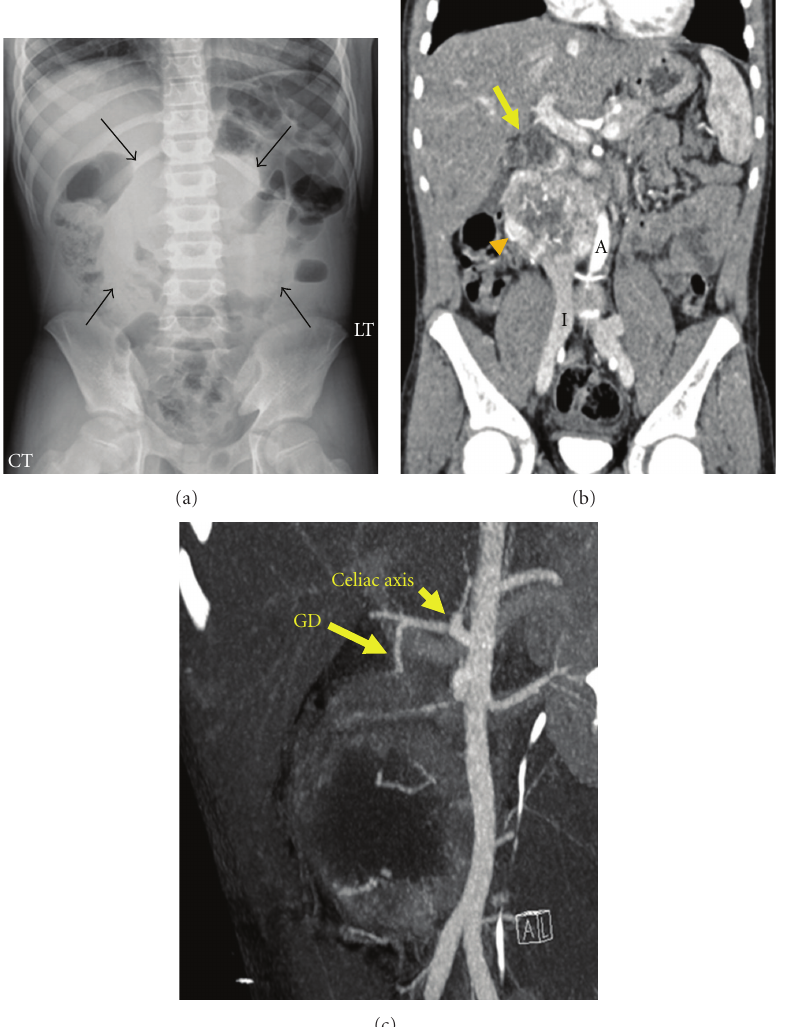
Figure 1: (a) Abdominal radiograph shows midline displacement of bowel loops by a soft tissue density (black arrows) without calcifications and no bowel obstruction. (b) Coronal CTA shows the markedly enhancing mass (orange arrowhead) displacing the aorta (A) and IVC (I) and its close proximity to the 3rd portion of the duodenum (yellow arrow). (c) A maximum intensity projection from the CTA depicts gastroduodenal artery GD (arrow) as the primary feeder of the